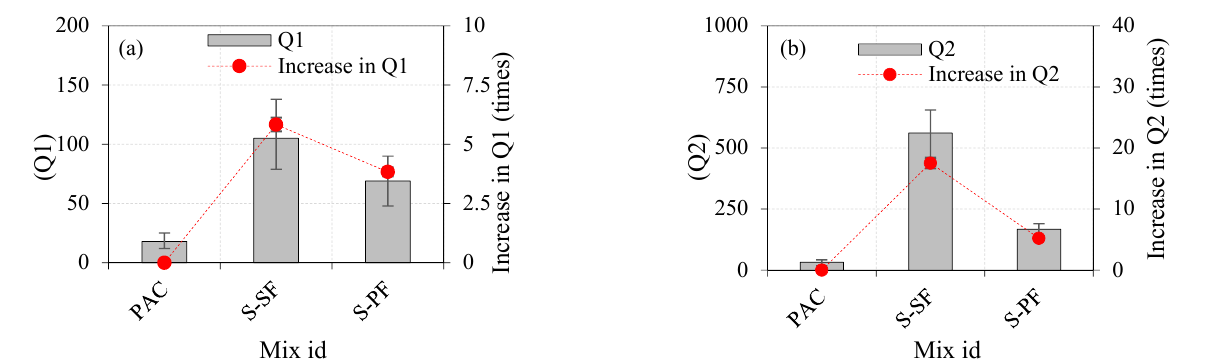
Figure 8. The effects of a single-layered specimen on the impact strength ( a ) Q1 ( b ) Q2.